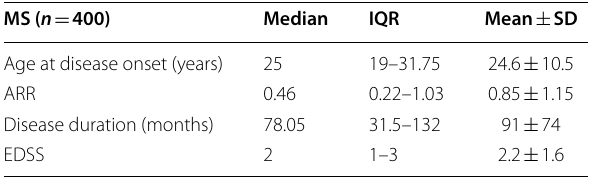
MS multiple sclerosis; IQR interquartile range; SD standard deviation; ARR annualized relapse rate; EDSS expanded disability status